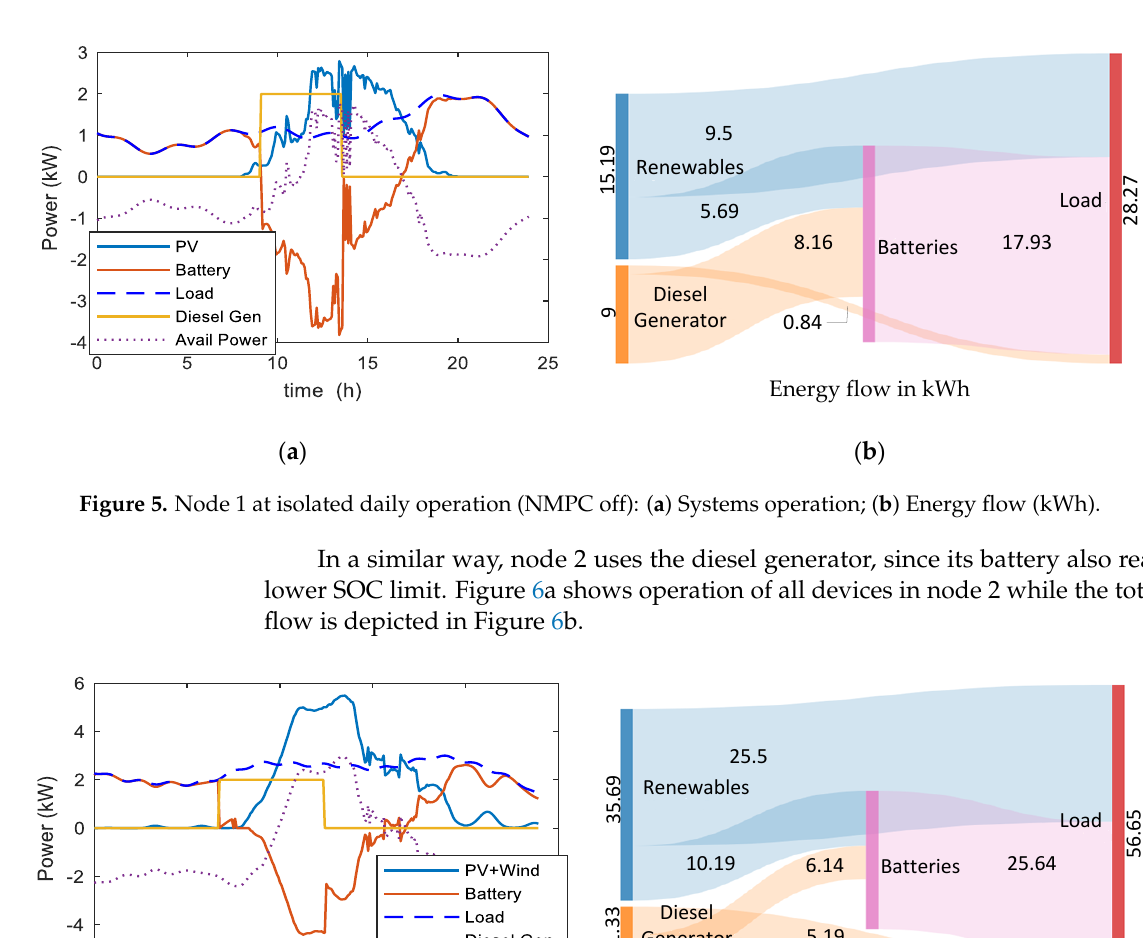
( b ) Figure 4. ( a ) Available power in the nodes; ( b ) Battery SOC in daily operation. The charging and discharging operation is observed in positive and negative avail- ability respectively. In the first and the second node, the diesel generators are activated when minimum SOC is reached while in the third node the water electrolysis device is activated at maximum SOC in order to exploit excess energy. A detailed operation of the power devices inside each node can be seen in Figures 5 – 7. Figure 5a shows that the load in node 1 (dashed line) is covered initially by the battery. Afterwards the RES are gradually beginning to contribute during the day. At approxi- mately 9:00 h, when the battery reaches the minimum SOC (55%), the diesel generator starts to operate offering 2 KW constant power to load demand and for the battery charging. During this period, battery is also charged from the RES. The generator stops as